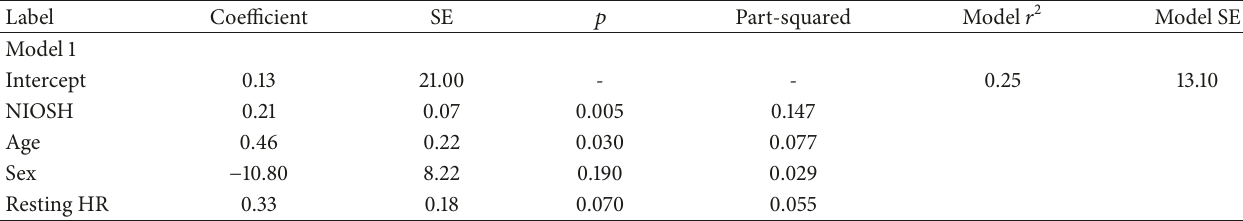
Table 5: Regression model for factors predicting stair climb with high-rise pack completion